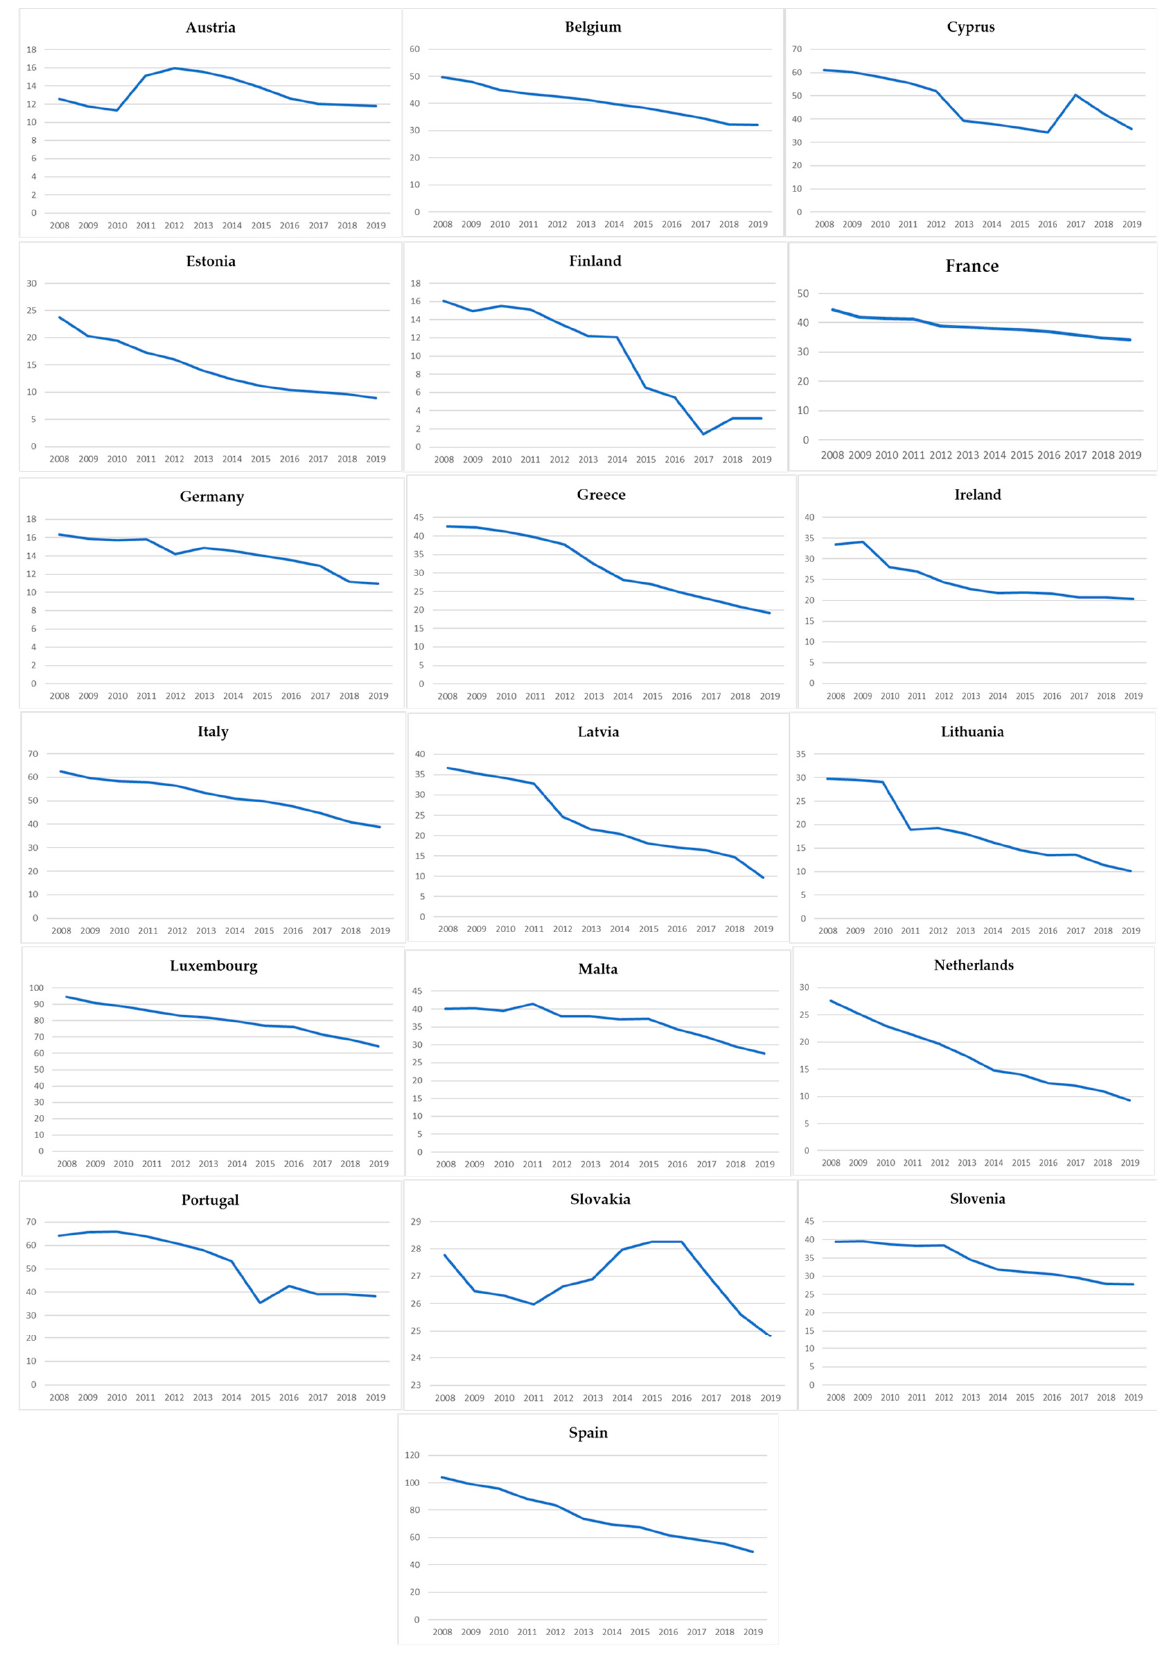
Figure 2. Bank branches per 100,000 adults (BB) in eurozone countries 2008–2019. For the period 2008–2019, we can observe a linear decrease in some countries (Croa- tia, Denmark, Hungary, Romania, and Sweden), while, for the rest of the countries, the decrease is not continuous, but followed by some small increase. Poland and the Czech